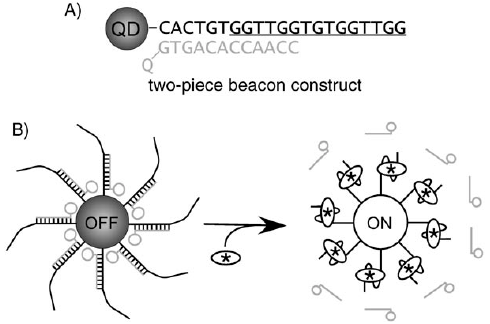
Figure 3. Design of a QD aptamer beacon for the detection of thrombin. ( A ) Anti-thrombin aptamer sequence (black) and quench oligonucleotide (gray). ( B ) Schematic for detection [48]. Some QD-aptamer beacon designs were also reported to realize label-free detection of thrombin [29,49], platelet derived growth factor (PDGF) [33], epithelial tumor marker mucin 1 [30], and cocaine [34,50], respectively.